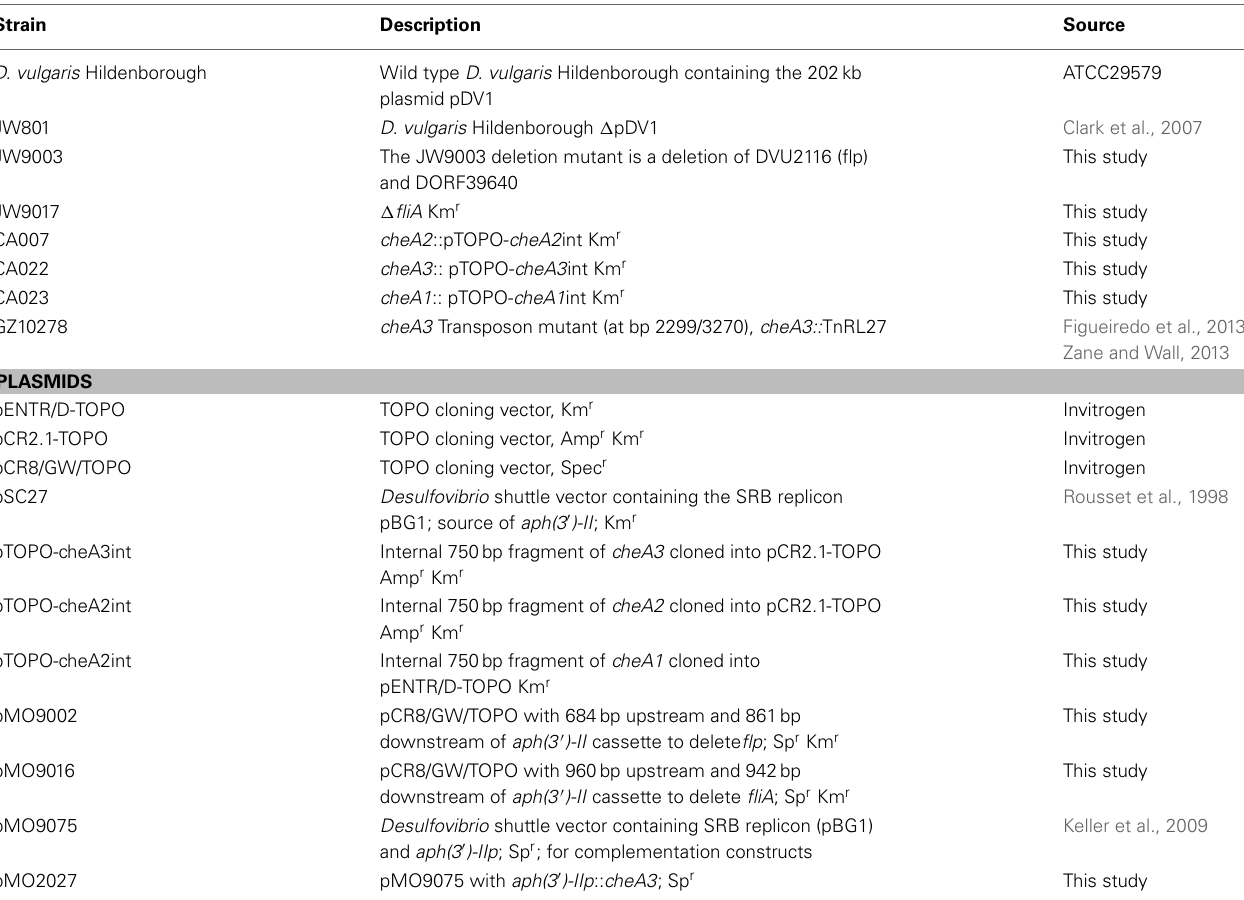
Table 1 | Strains and plasmids used.